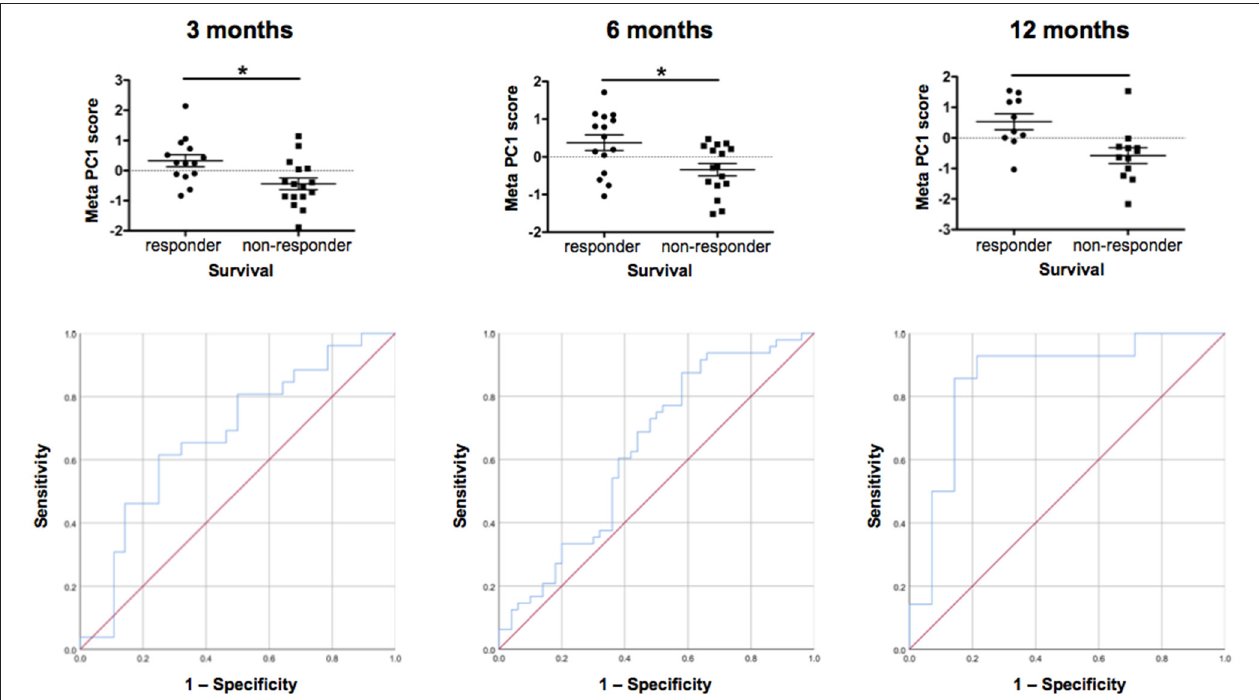
FIGURE 8 | Individual patient response. Comparison of individual patient response by meta-PCs and testing of ROC (sensitivity/specificity) at 3, 6, and 12 months. We generated meta-PCs from the significant PCs at 3, 6, and 12 months of filgrastim treatment and analyzed the relationship between the meta-PCs and individual treatment response. Responding and non-responding patients have significantly different mean meta-PC scores at all timepoints, with patients responding better to treatment exhibiting higher scores (LMM, all p < 0.01). The receiver operating characteristic (ROC) curves showed that the meta-PCs were significantly predictive of whether patients would have responded to treatment or not (at 3 months: AUC = 0.677, p = 0.026; at 6 months: AUC = 0.633, p = 0.023; at 1 year: AUC = 0.854, p < 0.01). Although there is already quite a good prediction at 3 months, this will be much more accurate at 12 months. * p <